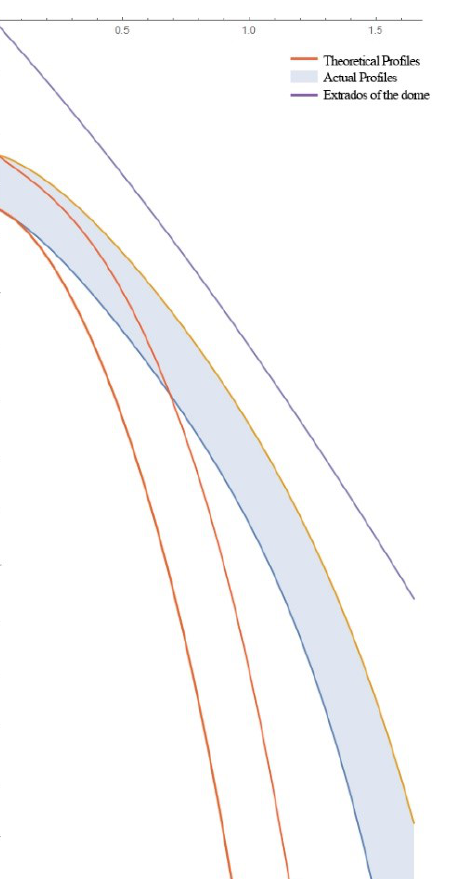
∘ ); (b) solution obtained for φ ∘ . 0 = 41.27 1 = 73.37